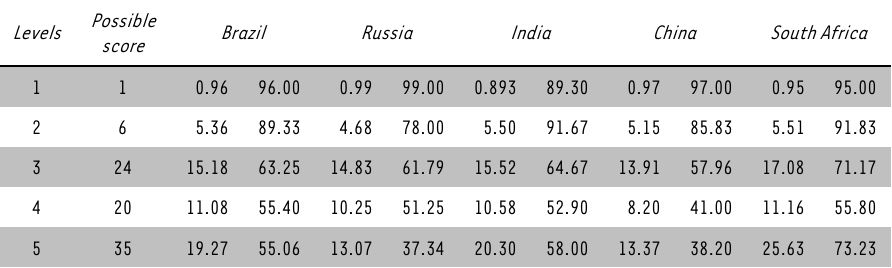
TABLE 7: Element 5 - Organisational relationships and culture Possible Levels Brazil Russia score